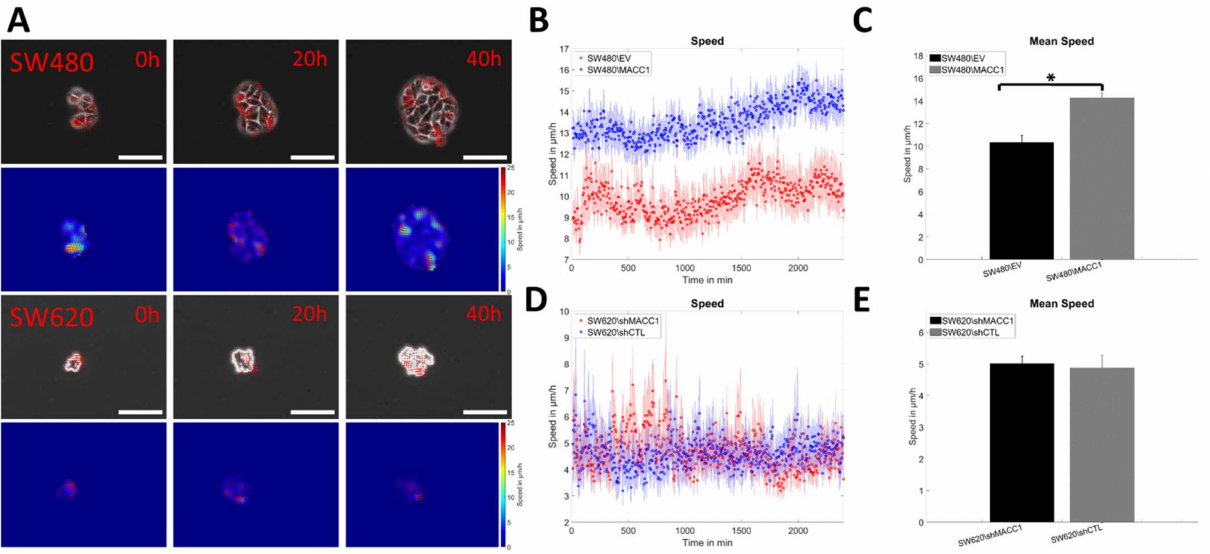
Figure 5. Expansion of small cell clusters. ( A ) Illustration of cluster expansion for SW480 and SW620 cells during the measurement time, together with the associated velocity maps. The scale bar depicts 50 µ m. ( B , D ) Plots of the cellular speed inside the clusters as a function of time for both cell types. ( C , E ) Temporal averages of the cell speed inside the clusters for SW480 and SW620 cells. Sample sizes: n SW480/EV = 14; n SW480/MACC1 = 14; n SW620/shMACC1 = 18; n SW620/shCTL = 17. Asterisk depicts statistically significant results with p < 0.05. Error bars and shaded areas depict the standard error of the